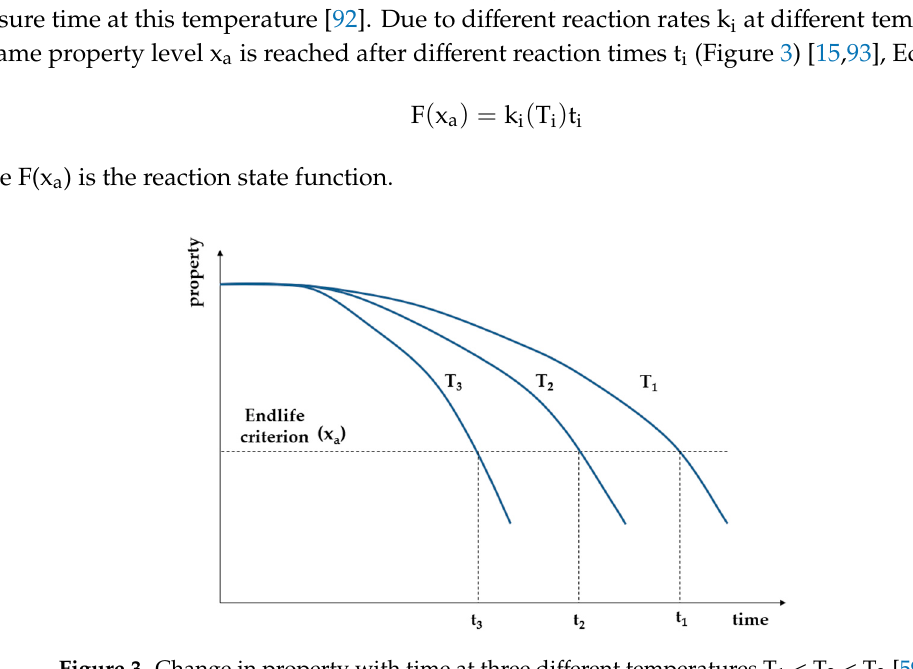
Figure 3. Change in property with time at three different temperatures T 1 < T 2 < T 3 [59].